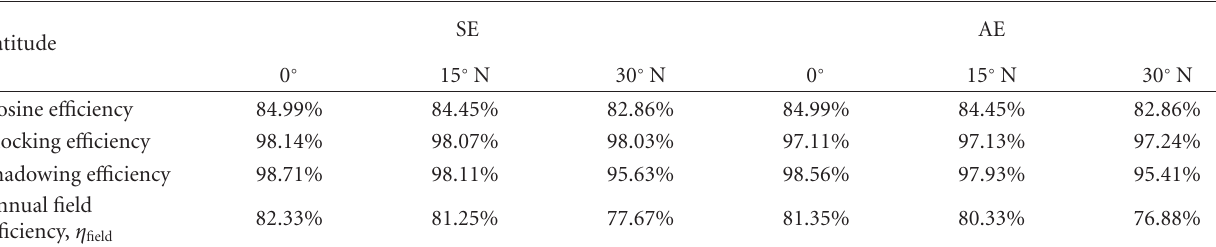
Figure 5: The flow chart to show the algorithm of computing the annual optical e ffi ciency of the heliostat in the field layout. Table 2: Annual e ffi ciencies of heliostat field for both sun-tracking